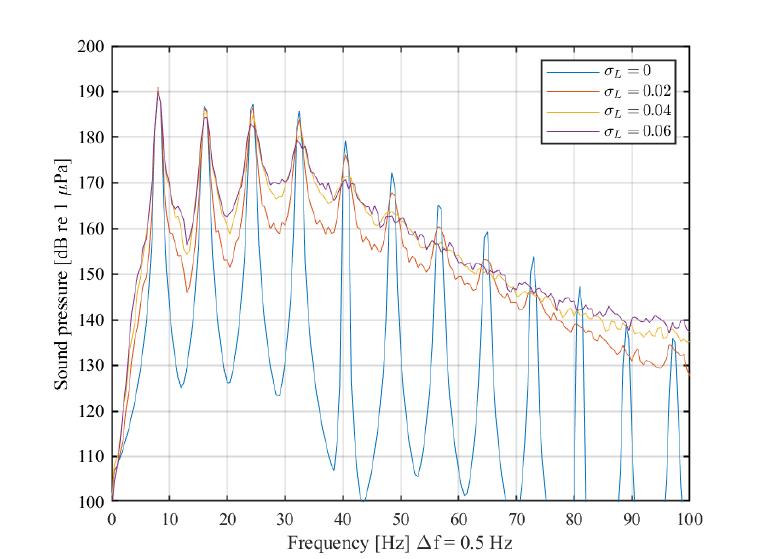
Figure 10. Sound pressure spectra of artificial signals generated by variation of the sequence length, i.e., the repetition frequency based on three different standard deviations σ L in comparison to the unvaried signal (blue line) for 96.5 rpm.